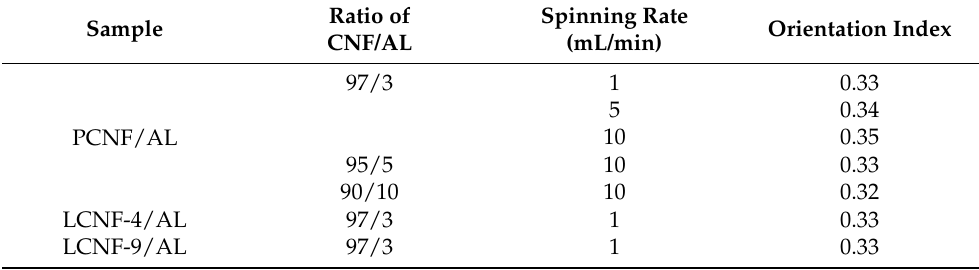
Figure 6. Azimuthal profiles of the (200) reflections from 2D XRD patterns of the wet-spun composite filaments made of PCNF/AL and LCNF-4/AL with different AL contents and spinning rates. Note: orientation index (OI). Table 4. Orientation index of wet-spun composite filaments from PCNF/AL, LCNF-4/AL, and LCNF-9/AL at different ratios of CNF/AL and spinning